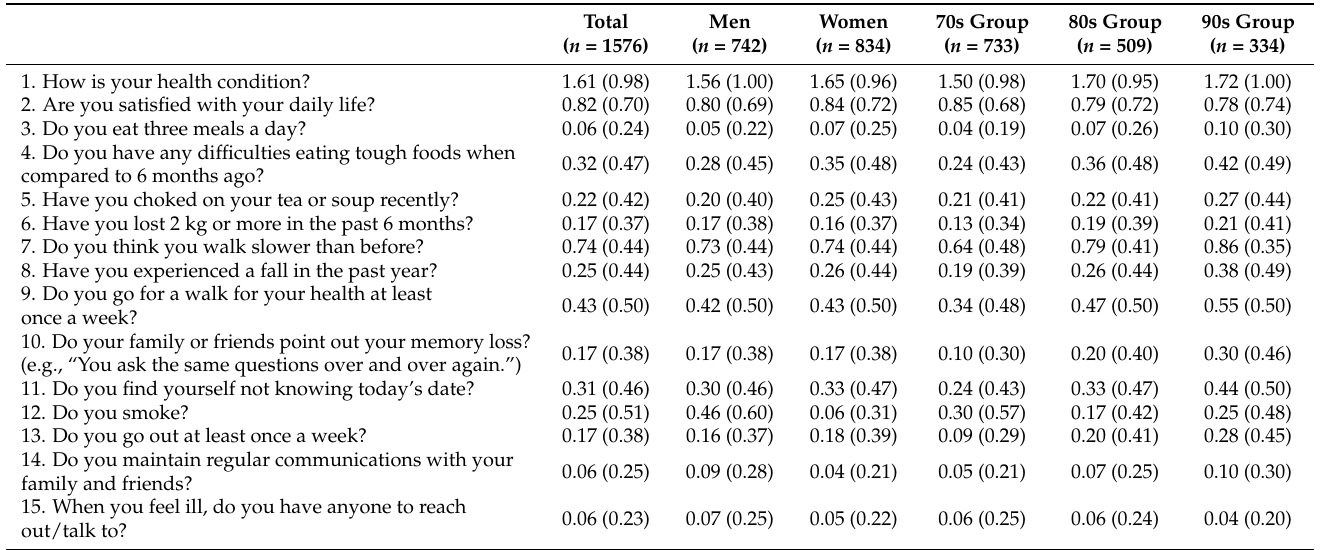
Table 3. Mean and standard deviation of each item in the health assessment questionnaire for old-old adults with 15 items by sex and age group.